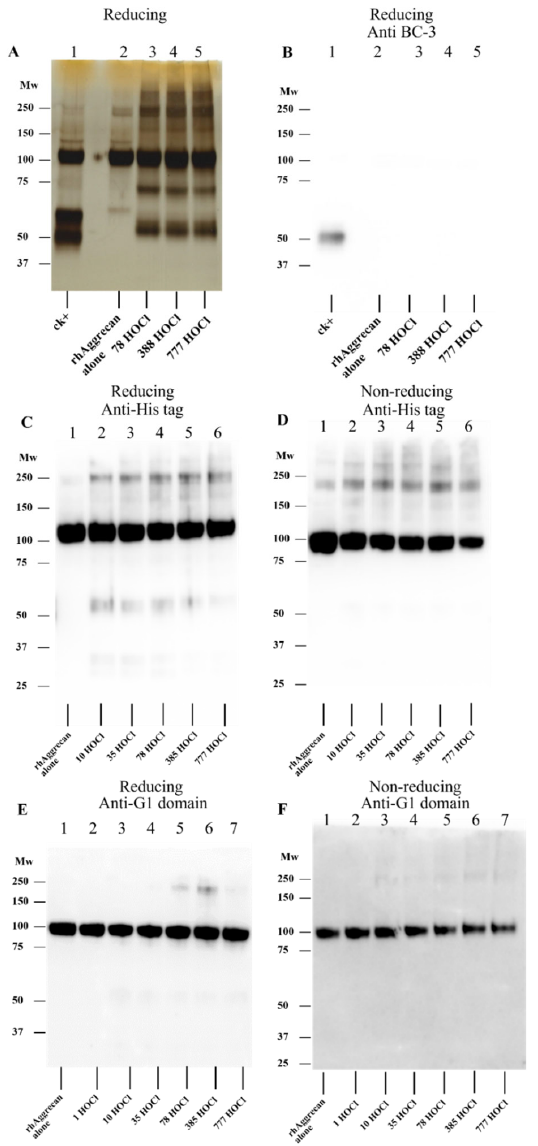
Figure 3. Investigation of HOCl ‐ induced rhAggrecan structural modifications by Western